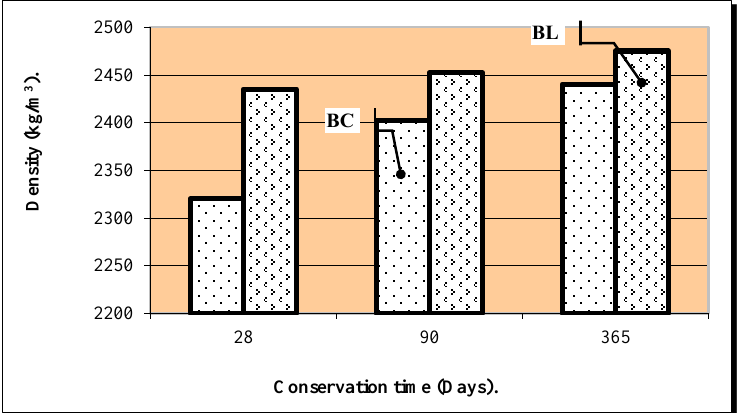
Fig. 3. Evolution of the concretes density as a function of curing